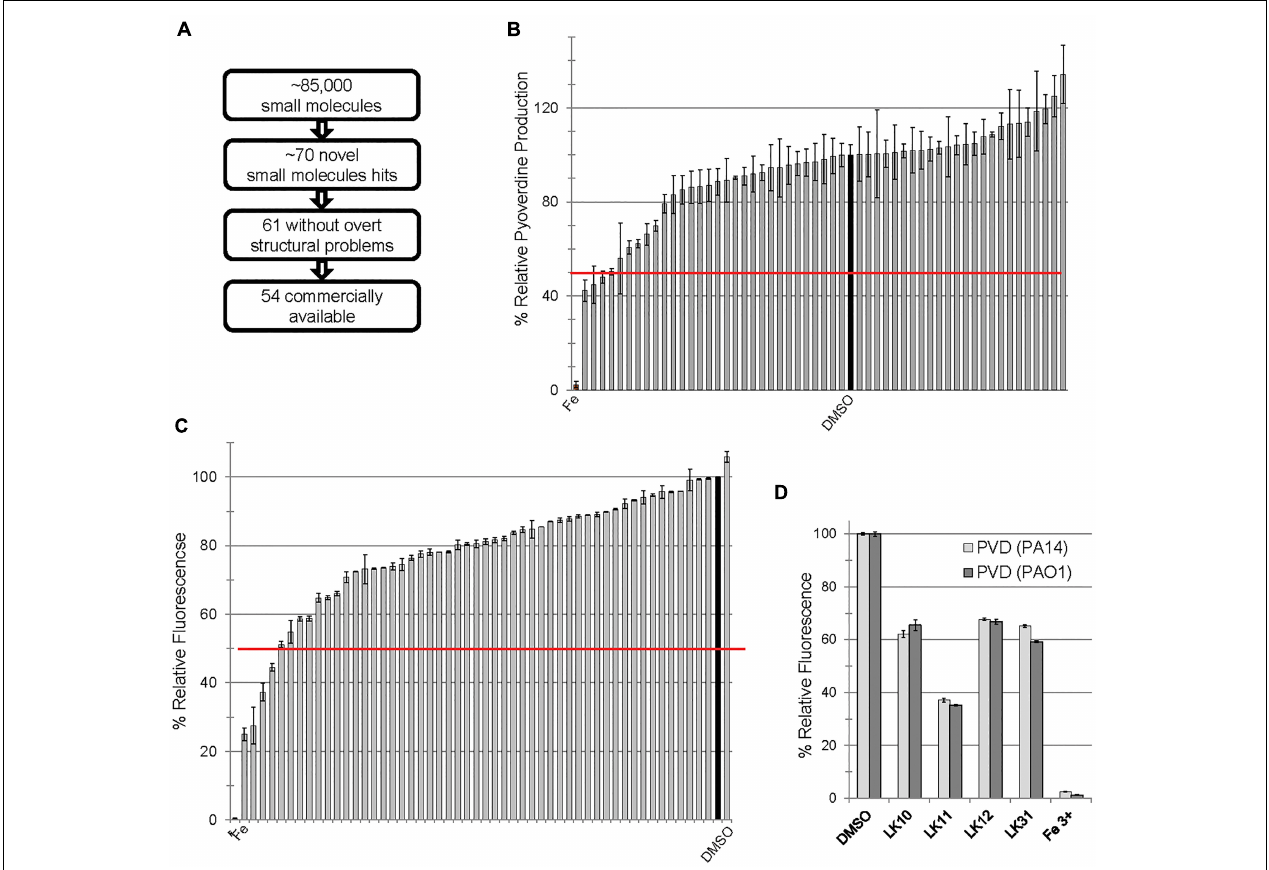
FIGURE 1 | Small molecules interfere with pyoverdine function. (A) Flow chart of screening summary for novel small molecules that rescue Caenorhabditis elegans from Pseudomonas aeruginosa . (B) Effect of small molecule hits on fluorescence of pyoverdine when bacteria were cultured 24 h in the presence of the compounds (250 µ M) or DMSO. (C) Fluorescence of pyoverdine in bacteria-free filtrate after a 5 min incubation with compound (250 µ M). (D) Selected small molecules are capable of quenching pyoverdine fluorescence from pyoverdine-rich filtrates produced by P. aeruginosa strain PA14 or PAO1. At least three biological replicates were performed for B–D . The red lines in B,C correspond to 50% decrease in